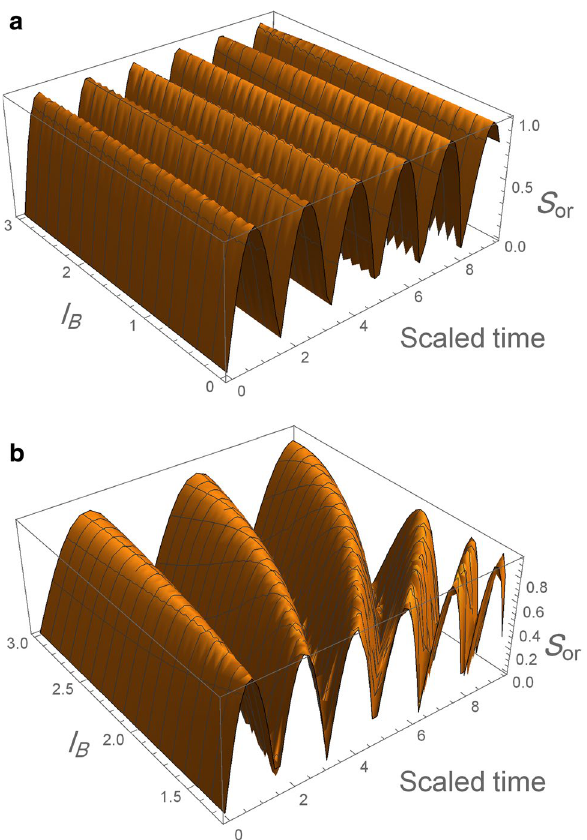
Figure 11. The orthogonality, S or , as a function of magnetic field ( l B ) when the system’s initial state in the maximum entangled state weak magnetic field in ( b